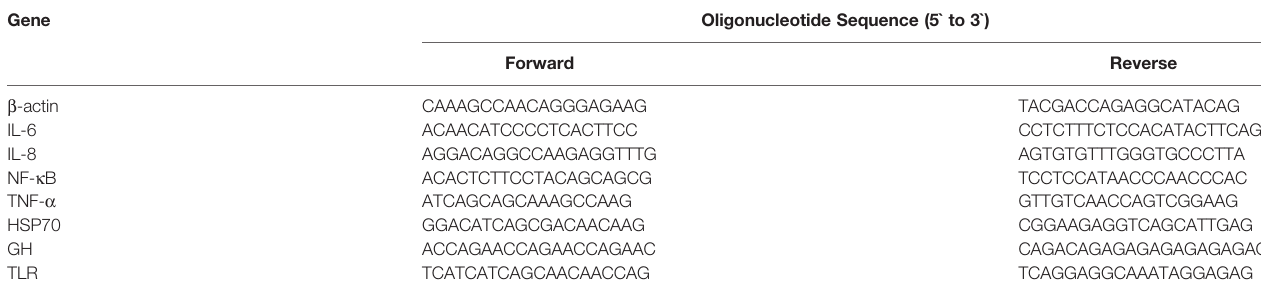
TABLE 2 | Gene-speci fi c primers used to quantify relative gene